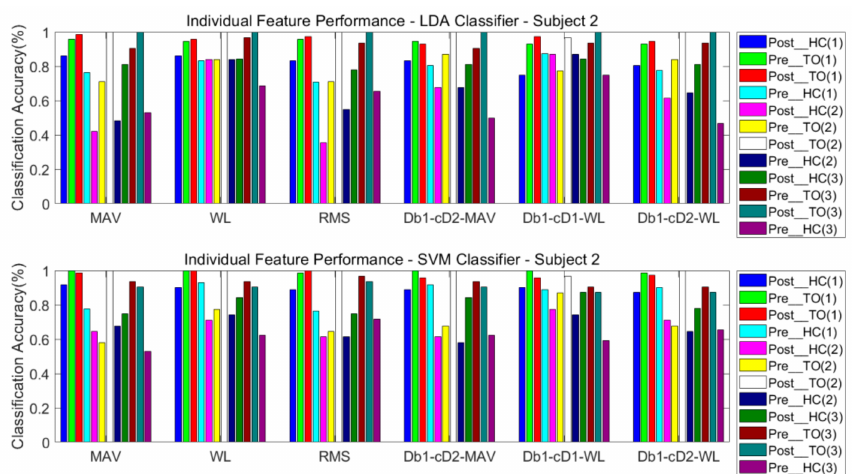
Figure 9. Classification performance of individual sEMG features; Subject #2.